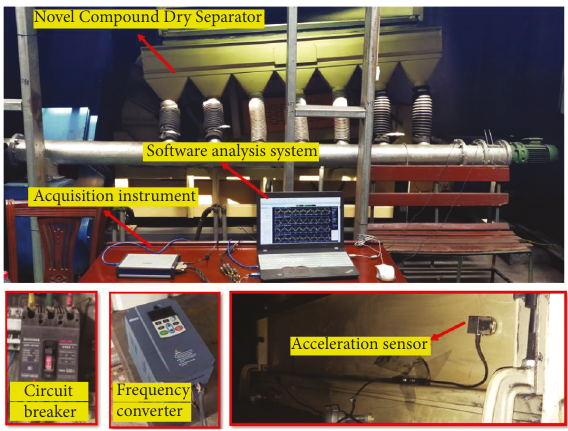
Figure 2: Arrangement of the experiment and analysis